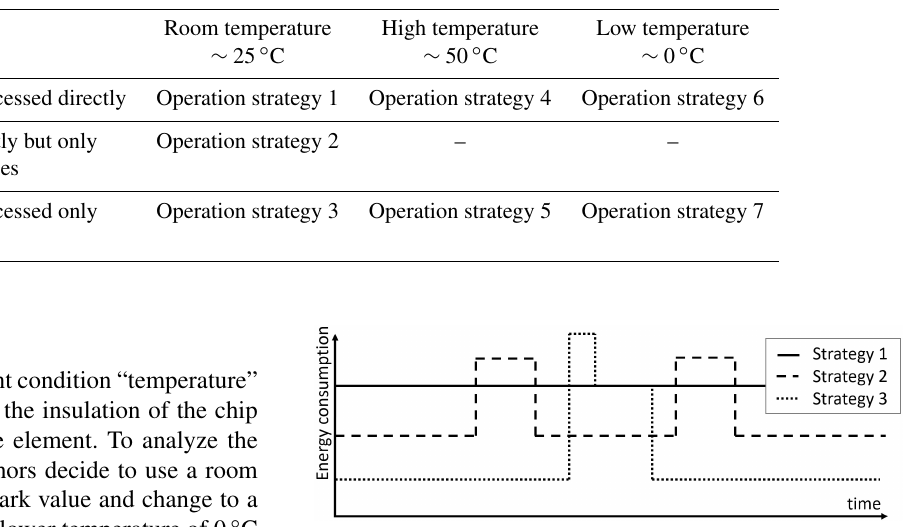
Figure 3. Assumed energy consumption of three different time- dependent strategies prior to the